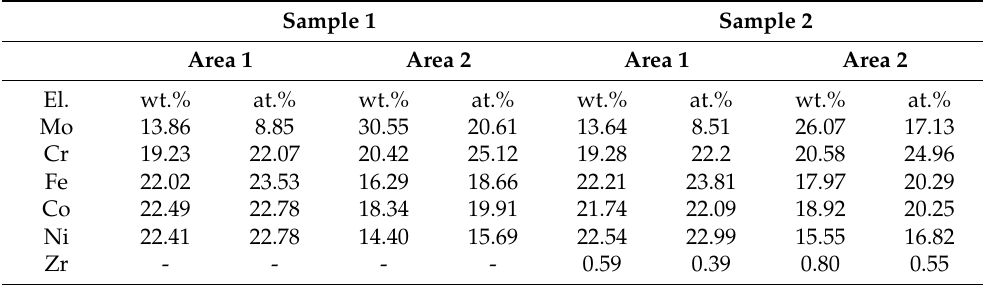
Table 3. EDS quantification